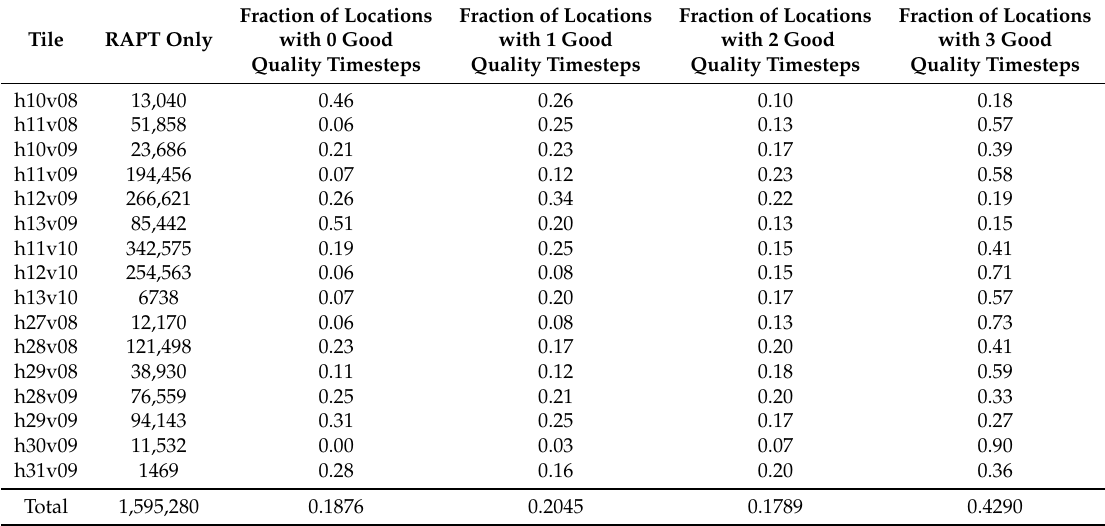
Table 3. Table shows the fraction of Only RAPT burned pixels with 0, 1, 2 or 3 good quality time steps out of the 3 time steps from date of burn event set.